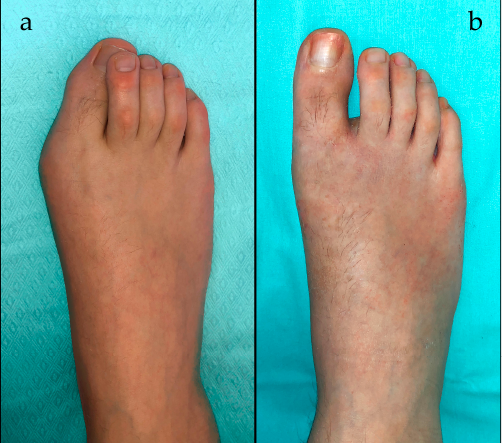
Figure 2. ( a ) Preoperative and ( b ) 12 months postoperative clinical documentation.